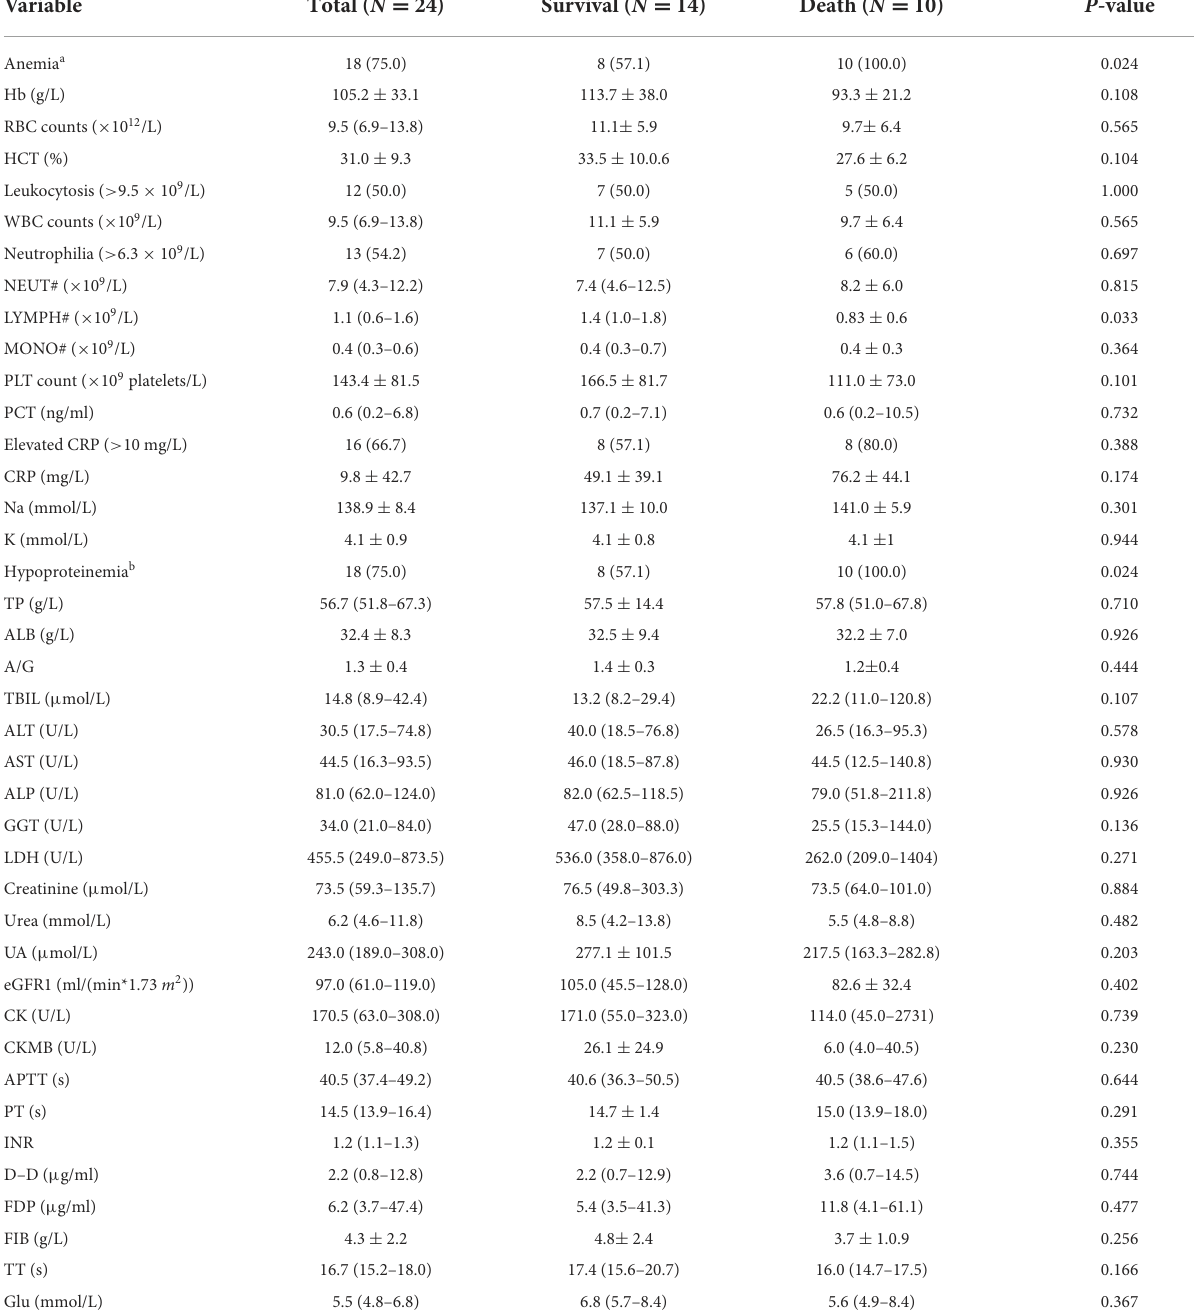
TABLE 3 Laboratory results of patients infected with E. meningoseptica ( N =